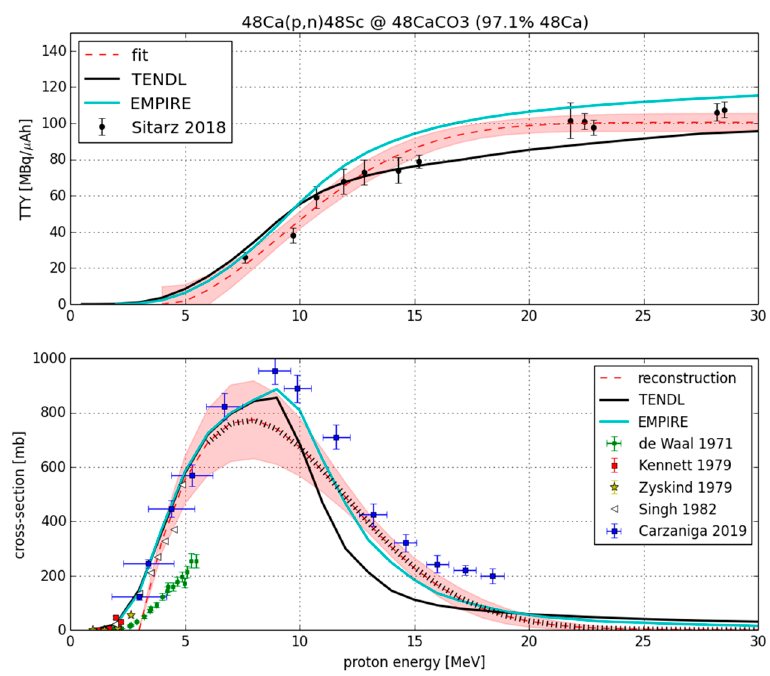
Figure 5. Reconstruction of 48 Ca(p,n) 48 Sc cross-section (bottom) based on the fit to TTY data on 48 CaCO 3 enriched in 97.1% 48 Ca (top). Here, we adopted an arbitrary threshold of 3 MeV. The cross-section data points are taken from [26–28,30,35]. The results from [27,28,30] are averaged.